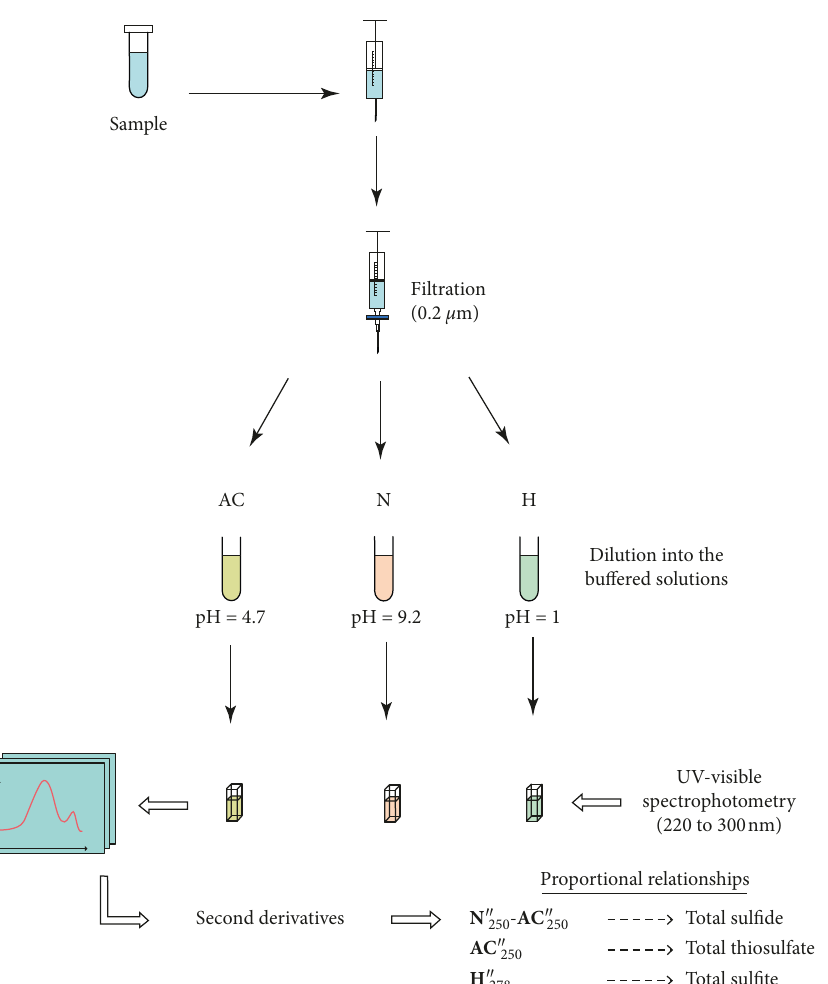
Figure 1: Schematic representation of the quantification procedure proposed in this study. From a filtered sample, three direct spec- trophotometric spectra are acquired in three different buffered media ( N , pH Spectra are differentiated to the second degree ( N 0 , AC 0 , and H 0 ), and values of second derivative absorbance are extracted at specific wavelengths ( N 0 250 , AC 0 250 at 250nm, and H 0 278 at 278nm). These values can be used to directly quantify total thiosulfate (H 2 S 2 O 3 /HS 2 O